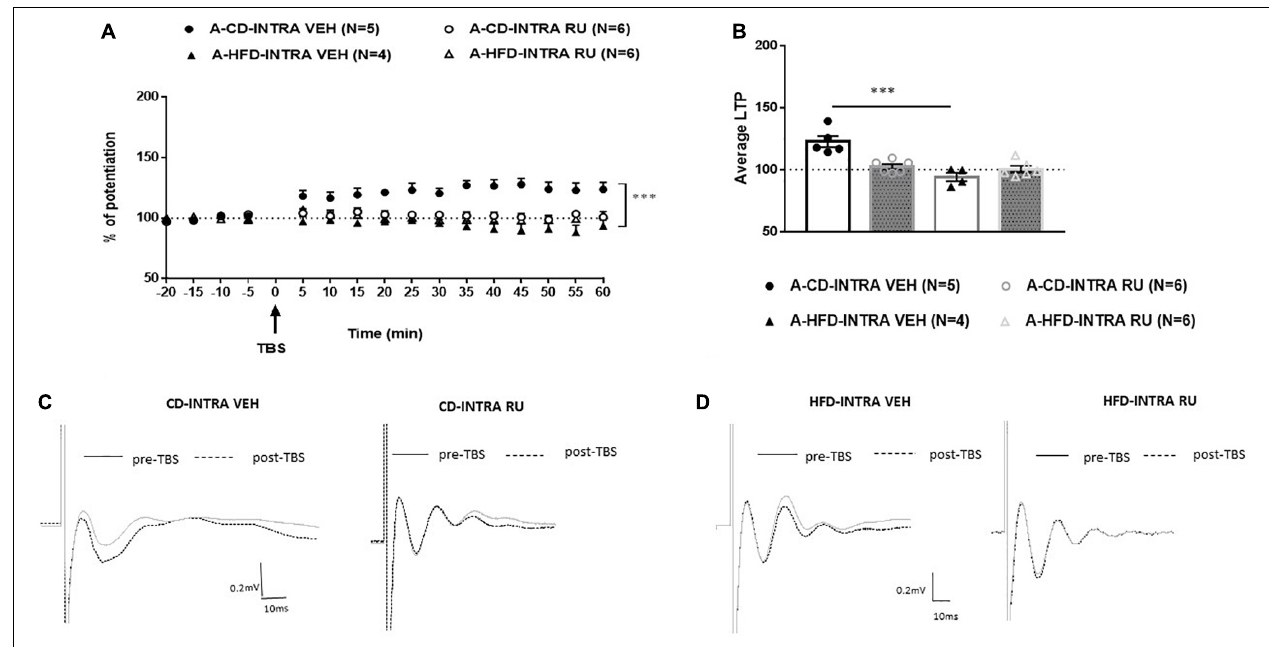
FIGURE 6 | Effects of local intra-mPFC GR blockade on prefrontal LTP in HFD- and CD-fed adults. (A) Normalized fEPSPs recorded in vivo before and after TBS of the BLA-mPFC pathway. Each data point shows the average fEPSPs of the preceding 5 min. (B) Average LTP shown in panel A over the 60 min after TBS. (C,D) Representative average waveforms before and after TBS Horizontal bar = 10 ms; vertical bar = 0.2 mV. For adult animals locally microinjected with GR antagonist RU-486 (RU) or vehicle 30 min prior to TBS. RU treatment had no effect on HFD-impaired LTP in HFD-fed animals, but impaired LTP in control CD-fed animals. Two-way ANOVA with repeated measures on the 12 time points after TBS showed significant effects of Diet ( ∗∗∗ p < 0.001) and Diet × Drug interaction ( ∗∗∗ p < 0.001), without an individual effect of Drug. Post hoc analysis showed a significant difference in CD-fed animals between vehicle and RU-486 groups ( ∗∗∗ p < 0.001), and no significant difference between HFD-treated groups. Error bars show standard error of the mean